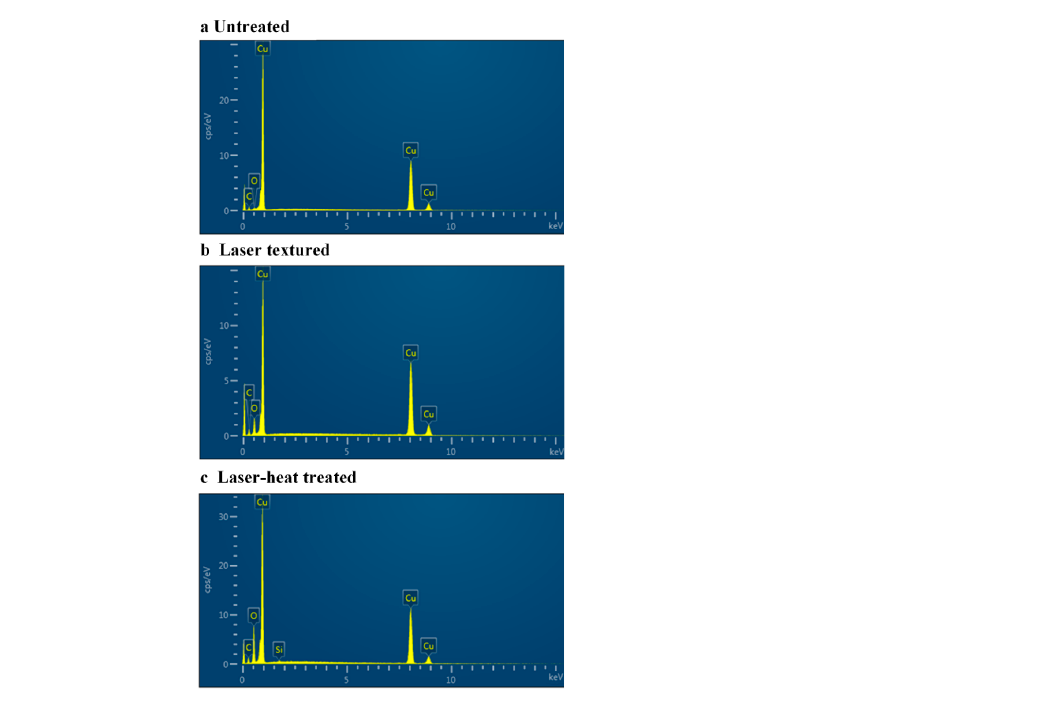
Figure 9. EDS measurement results for ( a ) untreated Cu foam; ( b ) laser-textured Cu foam; ( c ) laser- heat treated Cu foam. Table 2. Detailed atomic elemental compositions for untreated Cu foam, laser-textured Cu foam and laser-heat treated Cu foam.